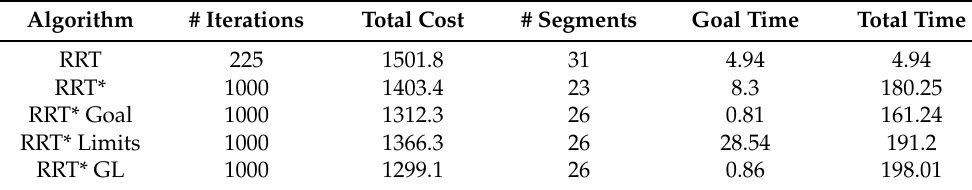
Table 6. Results. One obstacle, 1000 iterations.